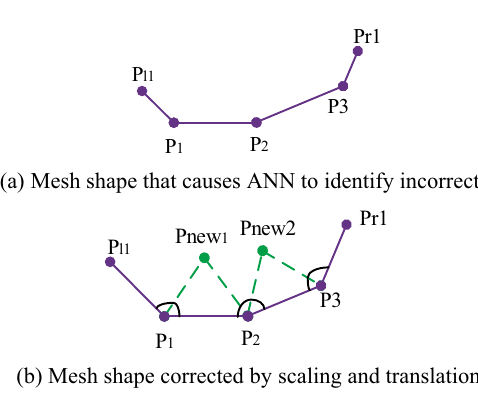
Figure 18. Special unreasonable geometric shape normalization